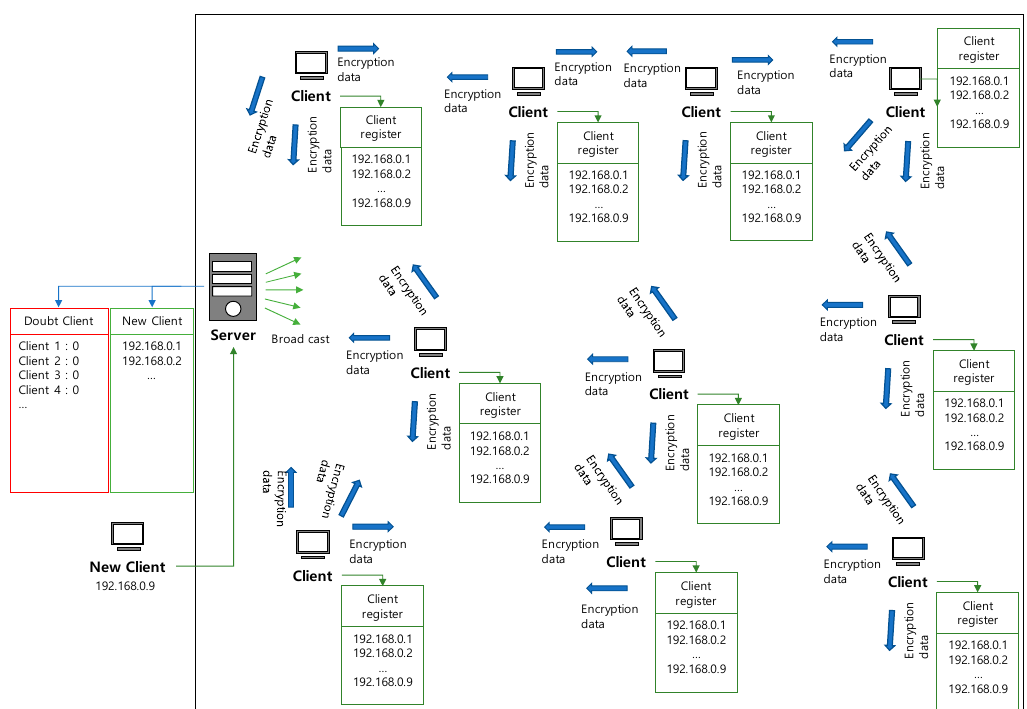
Figure 12. Overall structure of the system.